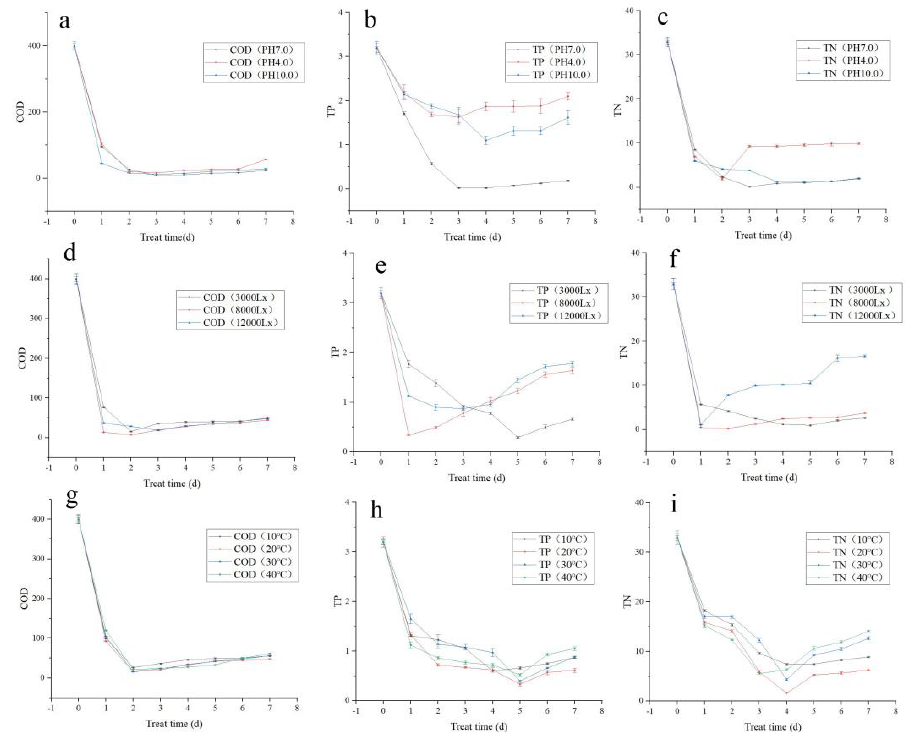
Figure 1. Orthogonal test verification of simulated municipal sewage treatment by Tibetan Desmodesmus sp.: ( a ) COD treatment trends under different pH conditions; ( b ) TP treatment trends under different pH conditions; ( c ) TN treatment trends under different pH conditions; ( d ) COD treatment trends under different light intensities; ( e ) TP treatment trends under different light intensities; ( f ) TN treatment trends under different light intensities; ( g ) COD treatment trends under different temperatures; ( h ) TP treatment trends under different temperatures; ( i ) TN treatment trends under different temperatures.